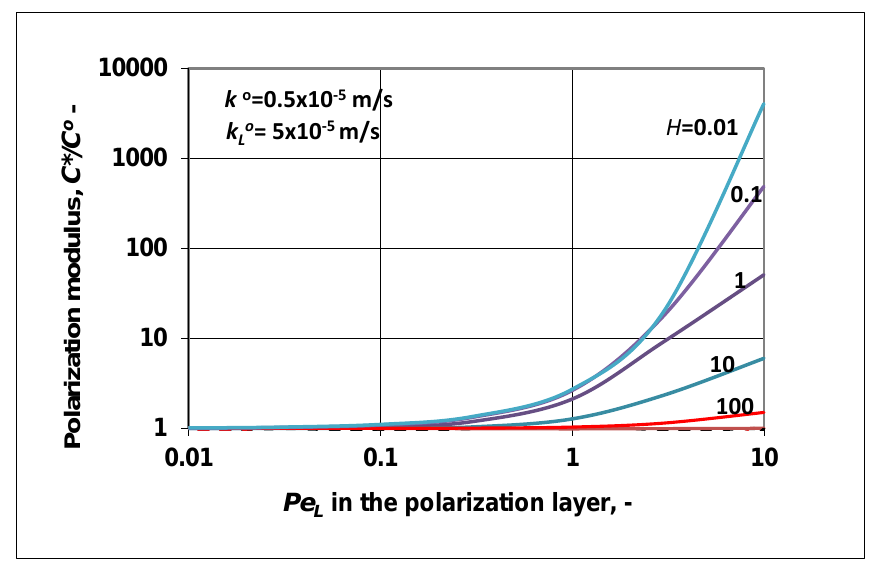
Figure 5. Polarization modulus as a function of the Peclet number of the polarization layer, at different values of the solubility, calculated by Equation (24); k o = 5 × 10 − 5 m/s; k o = 0.1 k o .